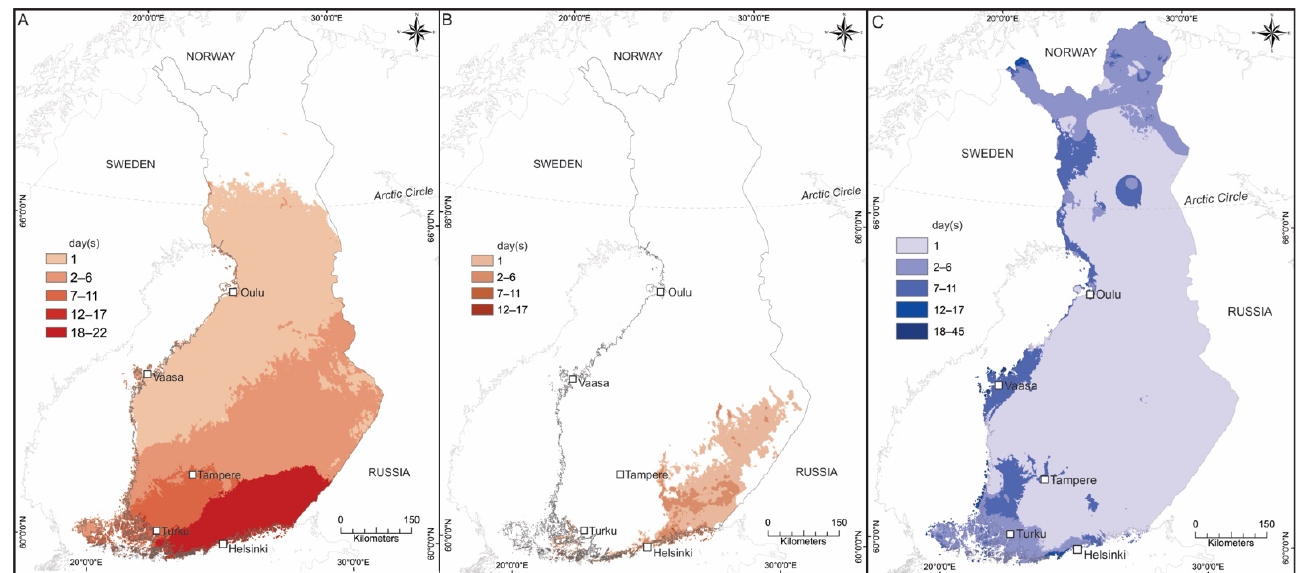
Figure 2. Mean air temperatures of ( A ) 18 °C, ( B ) 21 °C and ( C ) mean RH ≥ 70% in 2021 correspond- ing to experiment duration of 14 consecutive days (day(s) = 1). Number of additional days (after 14 consecutive days, day(s) ≥ 2) are indicated with a color gradient. 14 consecutive days, day(s) ≥ 2) are indicated with a color